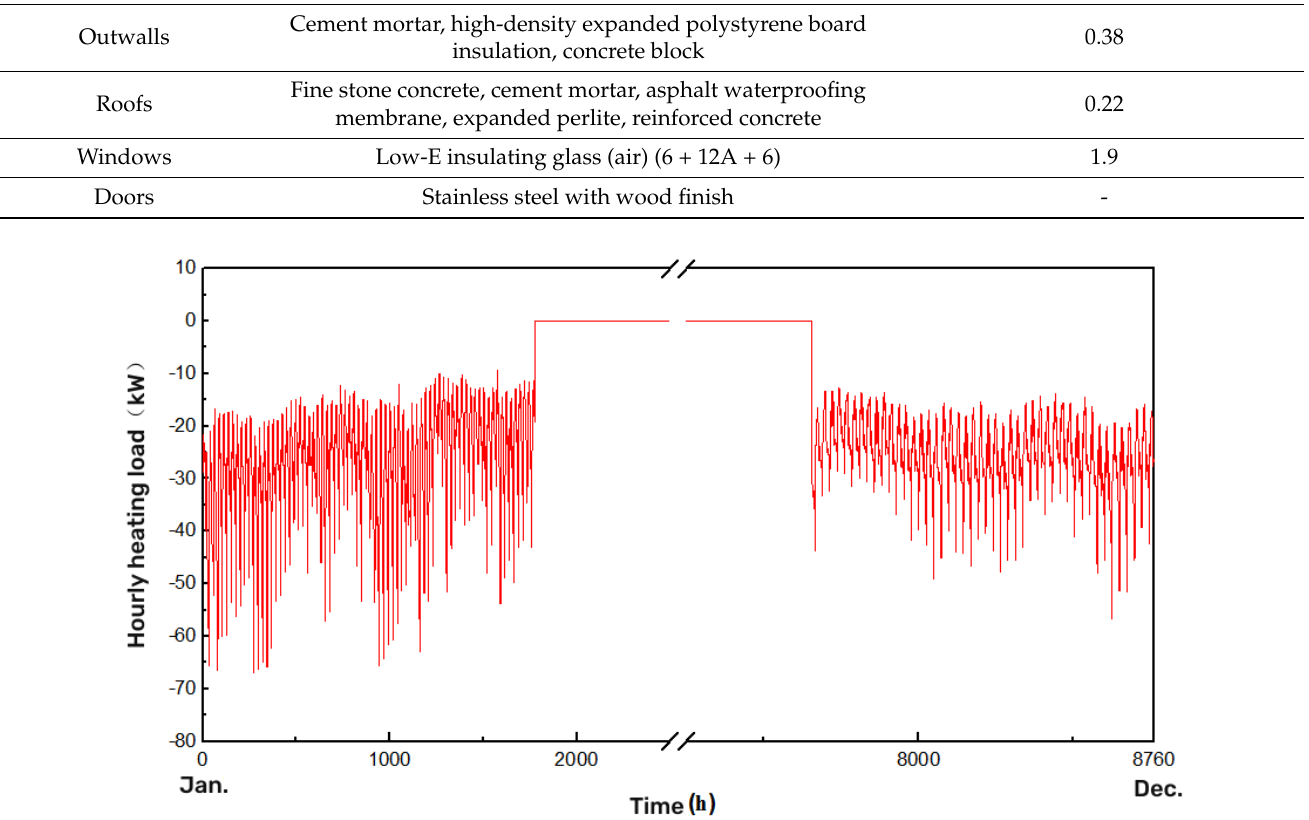
Figure 1. Hourly heating load change chart of the building during the heating period.